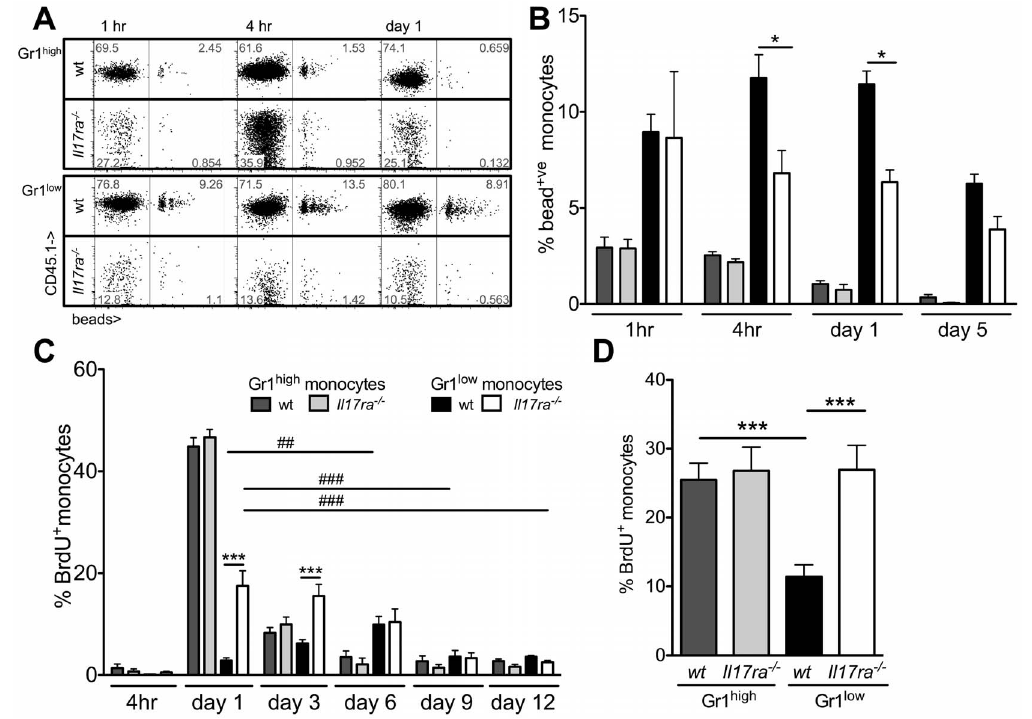
Figure 7. Kinetics of labeled Gr1 high and Gr1 low monocytes in the presence and absence of Il17ra -/- . ( A,B ) Monocytes in mixed chimeric wt/ Il17ra -/- mice were labeled with fluorescent latex beads (A). The proportion of labeled CD11b + CD115 + cells among each monocyte subgroup (Gr1 high and Gr1 low monocytes) within each genotype was assessed over time (B, n=4-5, 2 independent transplantations, Bonferroni after ANOVA). ( C ) Dividing cells in mixed bone marrow chimeric wt/ Il17ra -/- mice labeled with a single BrdU injection and peripheral blood monocytes were analyzed for BrdU incorporation at the indicated timepoints. In every animal, the proportion of labeled cells among Gr1 high and Gr1 low monocytes of either genotype was assessed over time (n=4, * indicates sign. differences between wt and Il17ra -/- Gr1 low monocytes at the indicated timepoints, # indicates a sign. change over time within wt (black bars) or Il17ra -/- (white bars) Gr1 low monocytes, analysis with Bonferroni after ANOVA). ( D ) Proliferation of bone marrow Gr1 high and Gr1 low monocytes of both genotypes was assessed 20 h after BrdU injection (n=7 from 2 independent transplantations, Bonferroni after ANOVA). doi:10.1371/journal.pone.0085461.g007 in mixed chimeric wt/ Il17ra -/- mice seven days after obstruction lower than wt in the unobstructed contralateral kidney. This was surgery (figure 9). UUO significantly enhanced renal CD11b + significantly enhanced in obstructive inflammation (figure 9B). leukocyte accumulation (figure 9A). Similar to other organs Differential recruitment was mainly due to monocytes and not (figure 4), the proportion of CD11b + Il17ra -/- cells was already neutrophils, which were 39 6 15% Il17ra -/- (p = 0.13, n= 6, 2